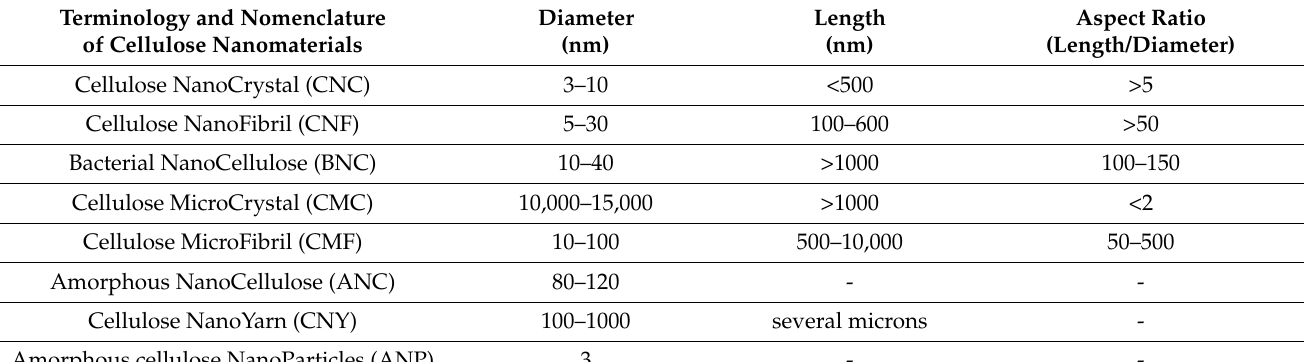
Table 1. Standard terms for CNMs (according to TAPPI WI 3021 [55]).